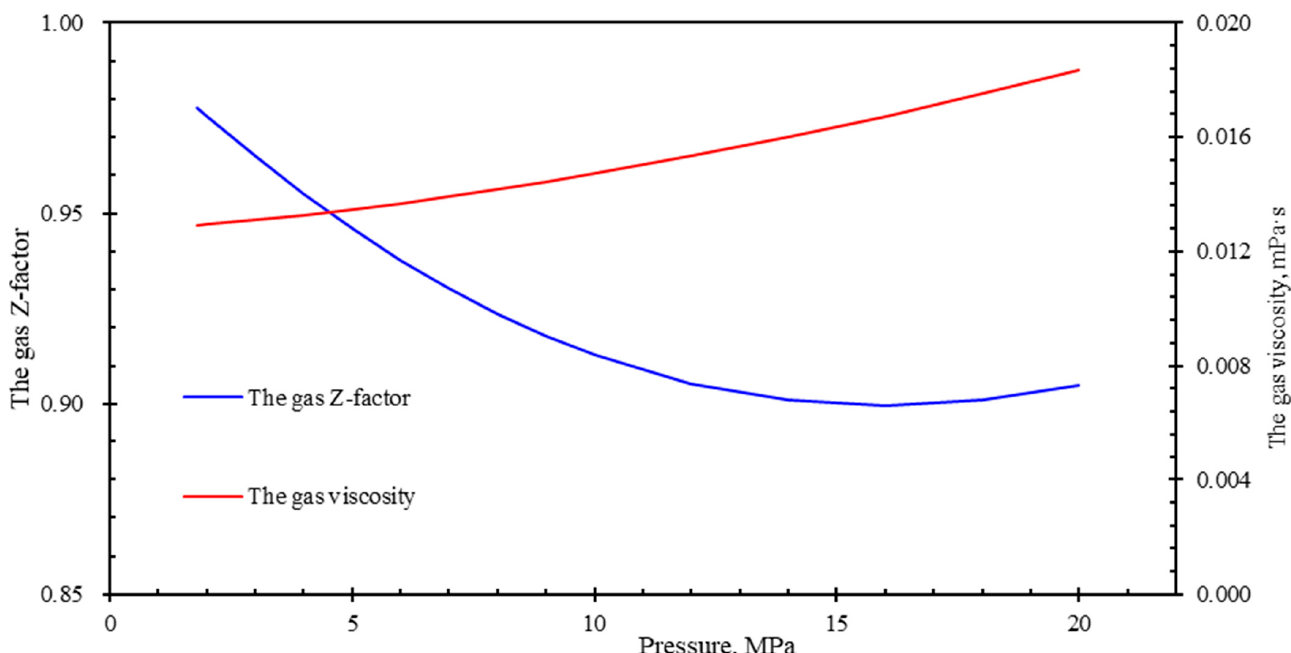
Figure 2. Gas Z-factor and viscosity used in the numerical simulation model.